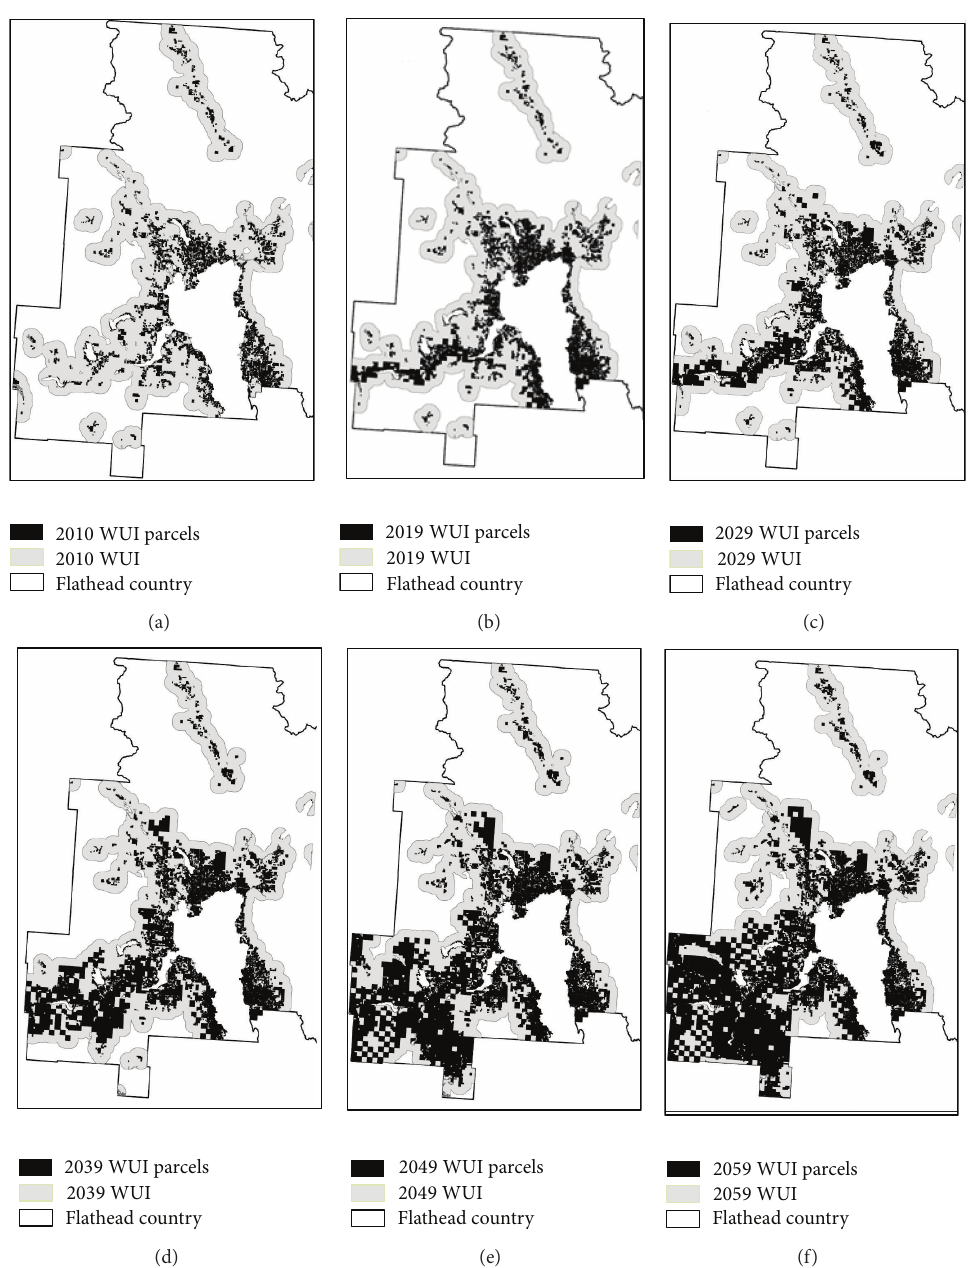
Figure 3: Simulated residential development of parcels in the WUI (dark areas) and the spatial extent of the WUI (light gray areas) for Flathead County, Montana, in 2010, and five